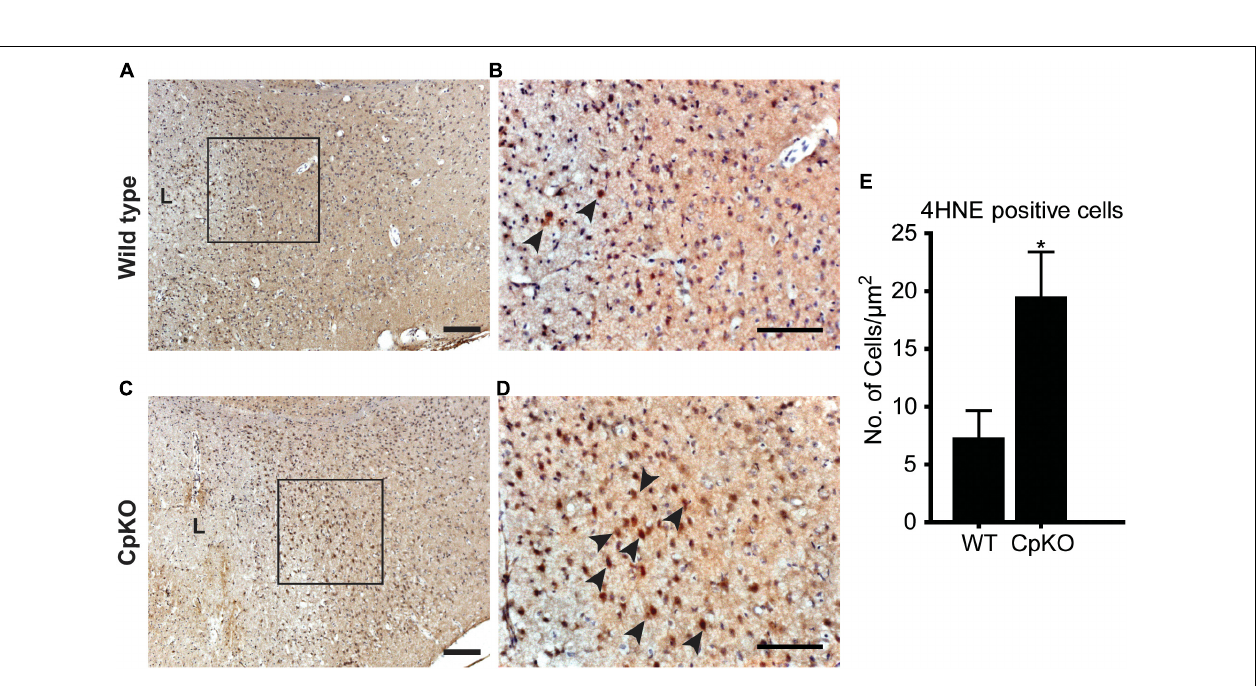
( Figure 9 ). No differences were noted between genotypes. The highest increases were detected at 24 h when IL-1 β increased by 15-fold, TNF α by 10-fold and IL-6 by about 55-fold. These values dropped markedly by 72 h but were still significantly higher in